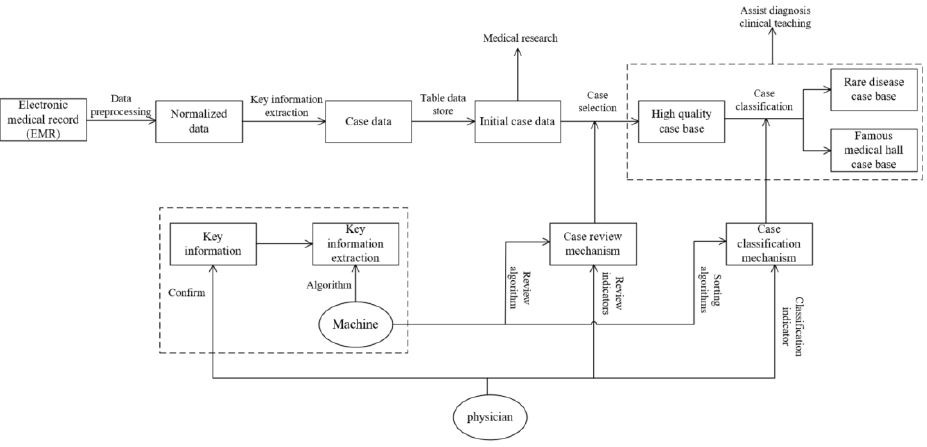
Figure 7. System data processing flow.